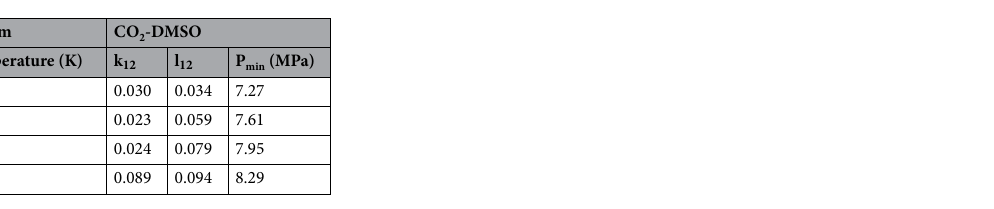
Table 3. Binary interaction parameters from PR-EoS with the vdW2 mixing rules for the binary system (CO 2 (1)—DMSO (2)).